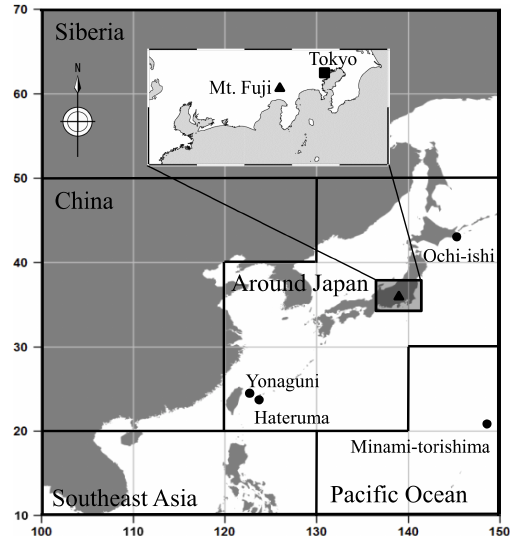
Figure 1. Location of Mt. Fuji (35.21 ◦ N, 138.43 ◦ E) and of other sites representative for the long-term observation of atmospheric CO 2 concentration in Japan (small black dots), and the five areas used for back-trajectory analysis of air mass origins (Siberia, China, Southeast Asia, around Japan, and Pacific